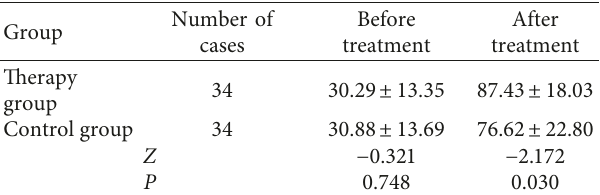
Table 4: Comparison of Nerve Palsy Scale scores before and after treatment.